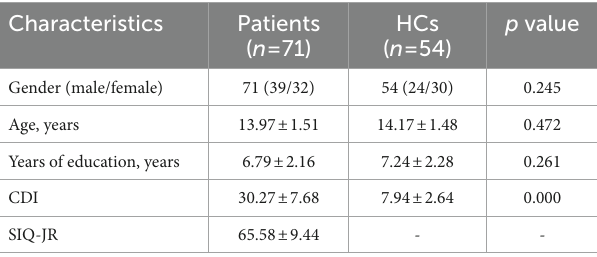
TABLE 1 Characteristics of the